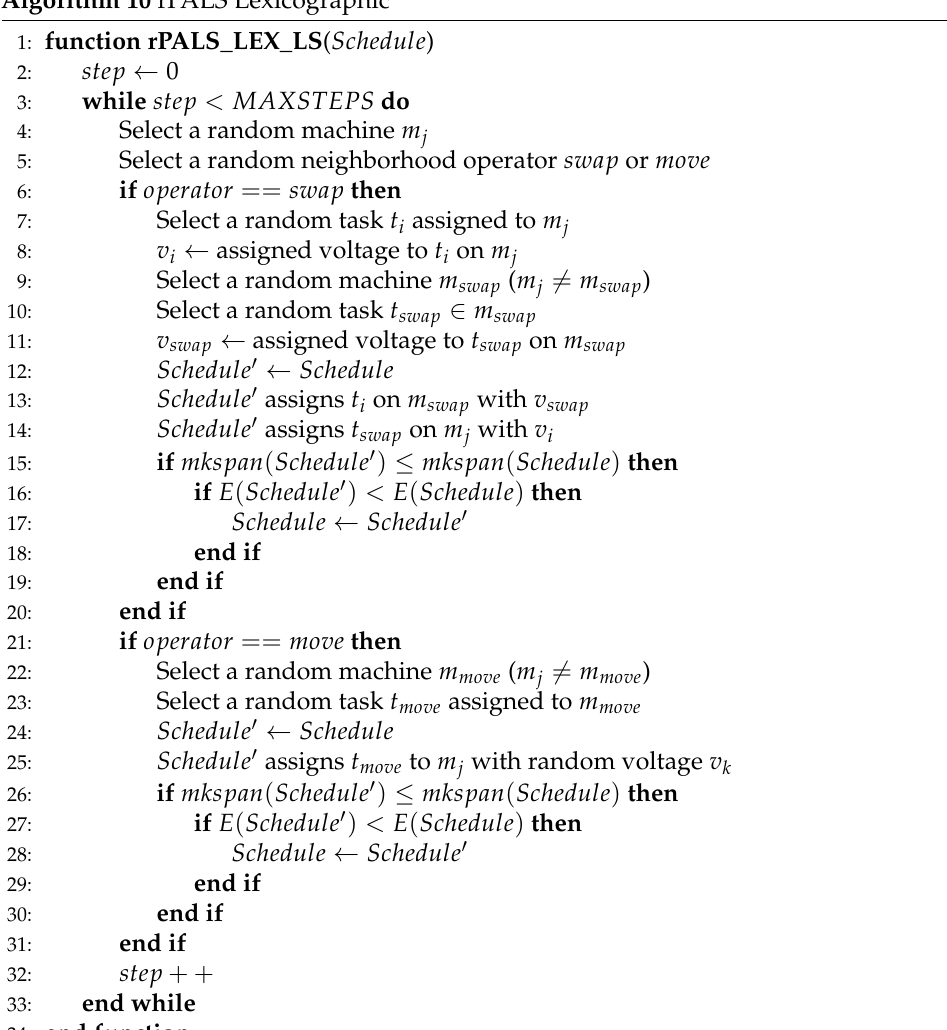
Algorithm 10 rPALS